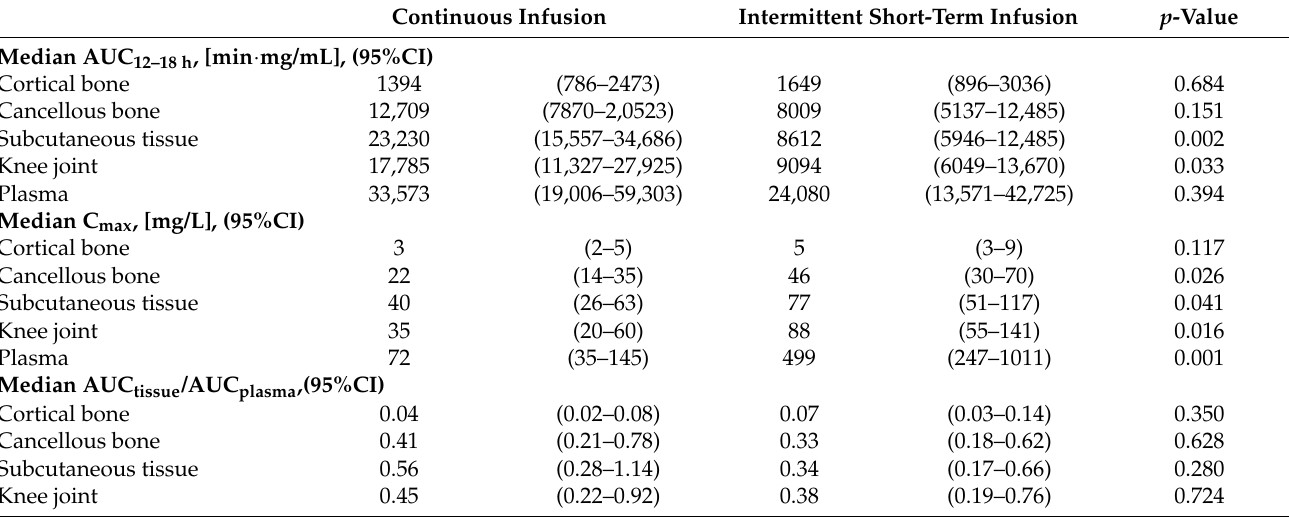
Table 2. Key pharmacokinetic parameters of piperacillin in the third dosing